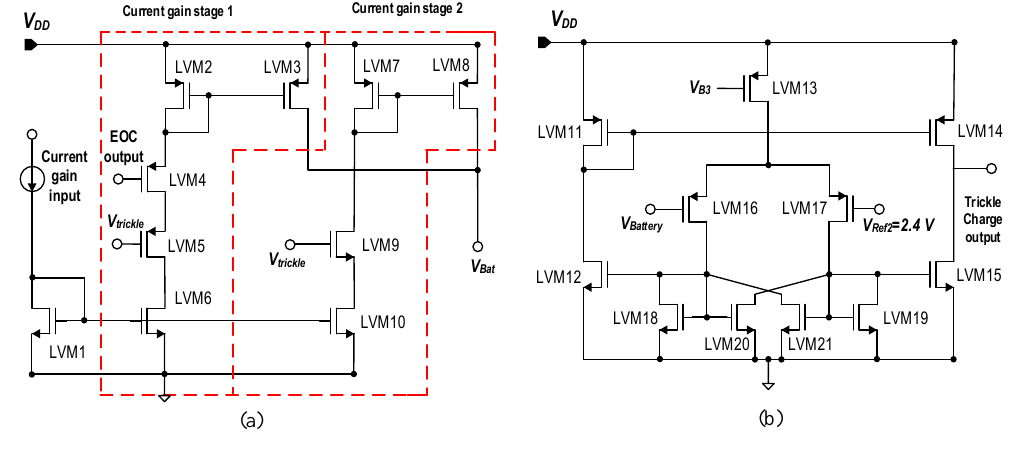
Figure 10. Schematic diagram of: ( a ) the implemented current gain; stages ( b ) the